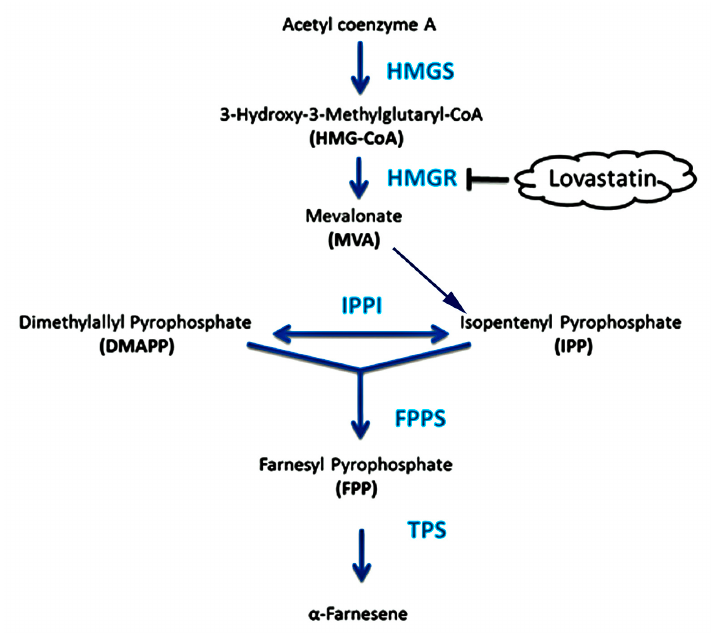
Figure 2. Proposed biosynthesis of α -farnesene in J. sambac ‘Bifoliatum’ where major enzymes include 3-hydroxy-3-methylglutaryl coenzyme A synthase (HMGS), 3-hydroxy-3-methylglutaryl coenzyme A reductase (HMGR), farnesyl pyrophosphate synthase (FPPS), and terpene synthase (TPS). Lovastatin is an inhibitor to HMGR.